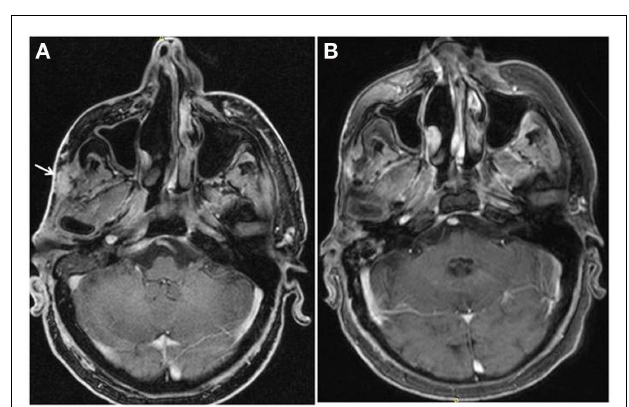
FIGURE 1 | Complete resolution of temporal soft tissue mas after six months of treatment with abiraterone.